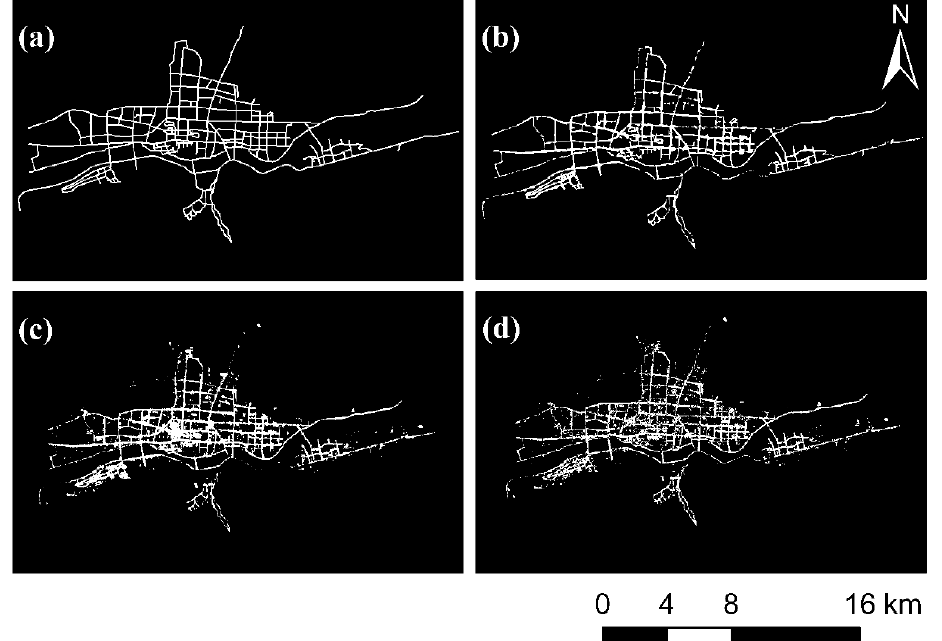
Figure 5. Extracted roads of Chengguan District from ( a ) OSM road network data, ( b ) BO-MWSA, ( c ) OT, and ( d ) SVM.